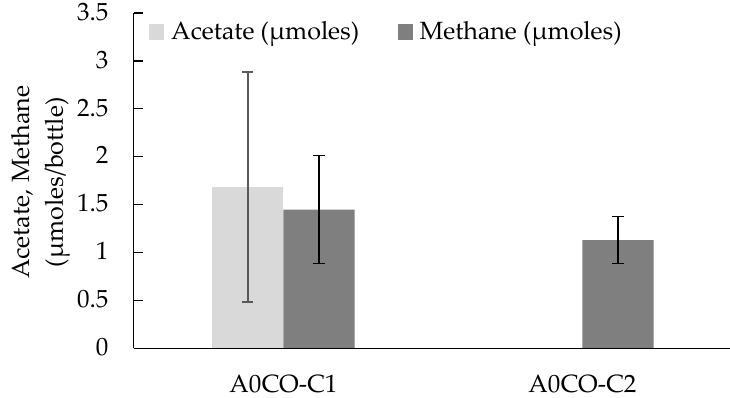
Figure 3. Acetate production and methane generation for conditions A0CO-C1 and A0CO-C2. The condition A0CO-C1 was studied using 1g humin / bottle, whereas no humin was added to the condition A0CO-C2. The vertical bars are representative data of the triplicates studied for two weeks incubation, with the vertical lines as the standard deviation.